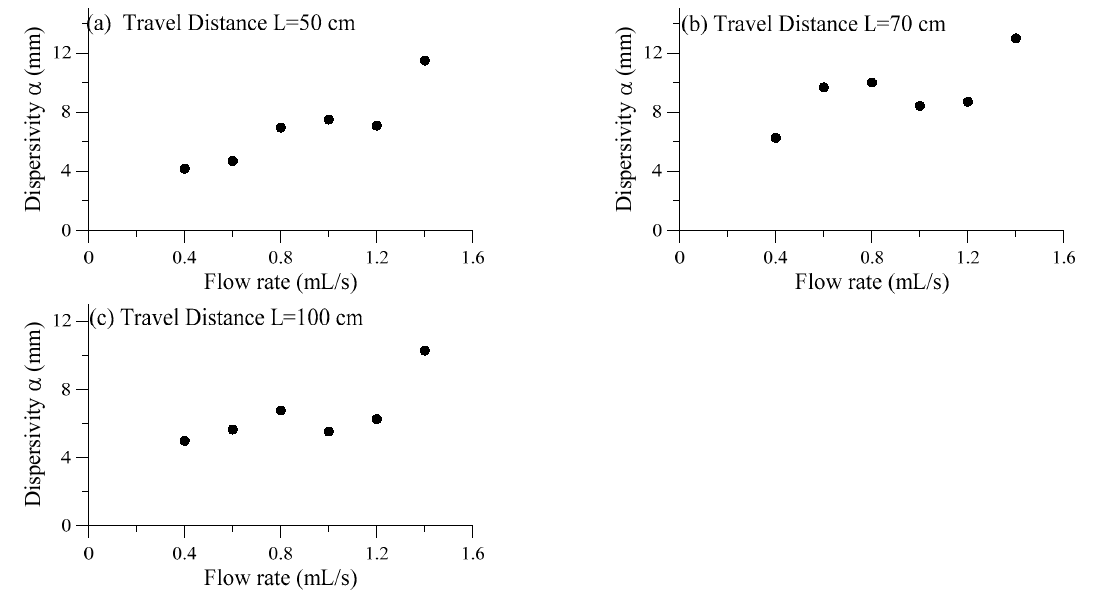
Figure 4. The best-fit dispersivity in the ADE model versus the water flow rate.